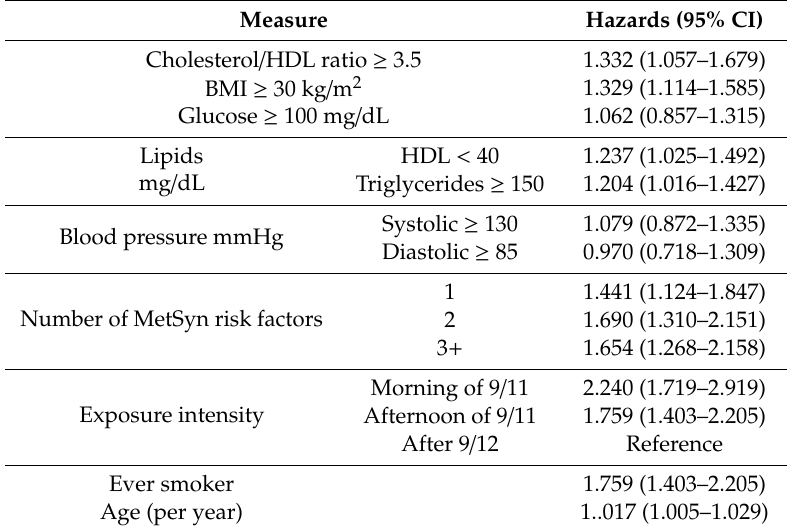
Table 3. Cox proportional hazards of univariate metabolic risk factors of